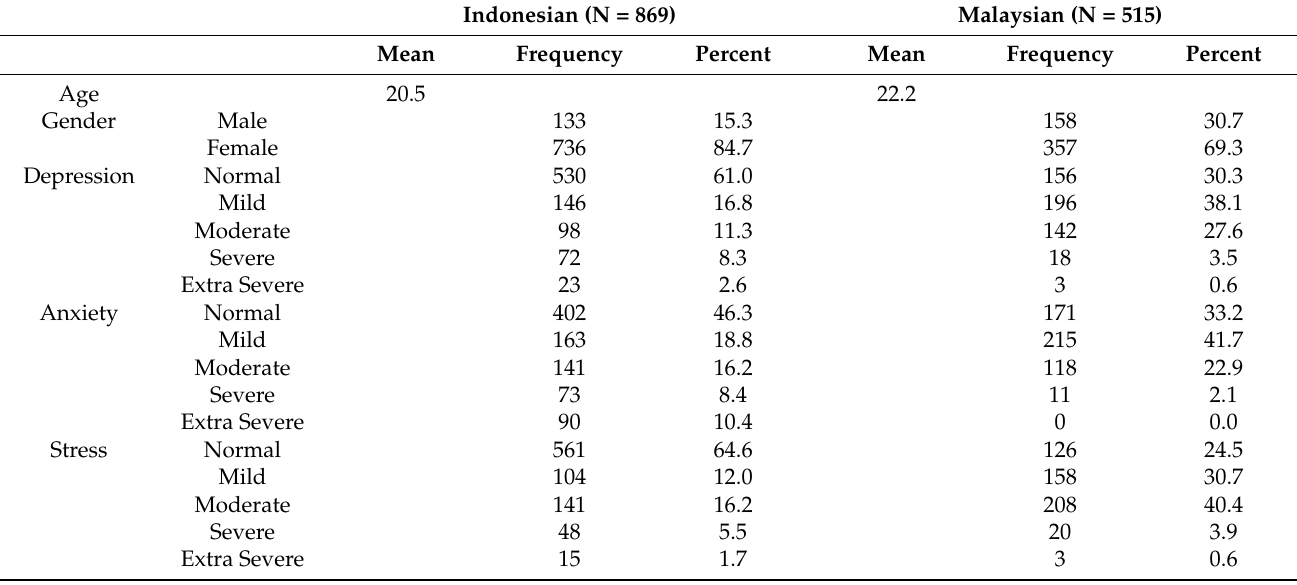
Table 3. Descriptive analysis of respondents.